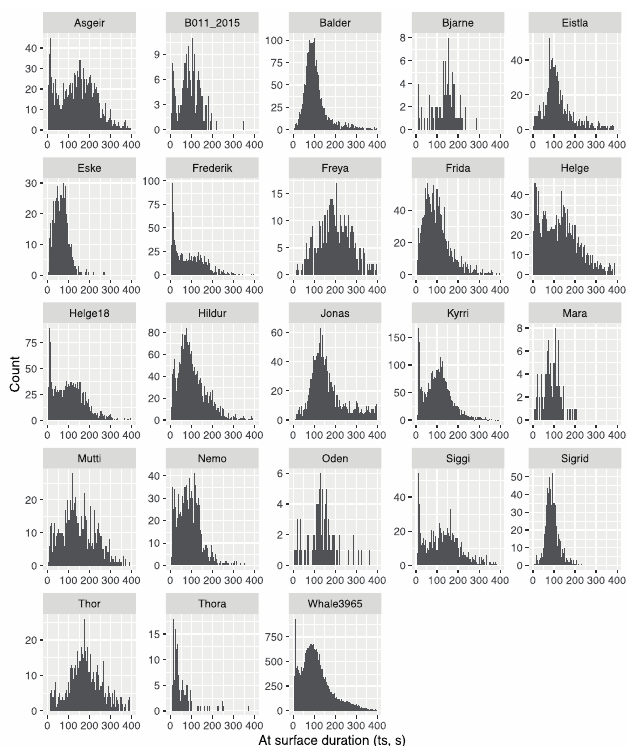
Figure 7: Histograms of the distributions of the duration of time spent at the surface (<2m. t s ) for the 23 whales from East Greenland with high resolution dive